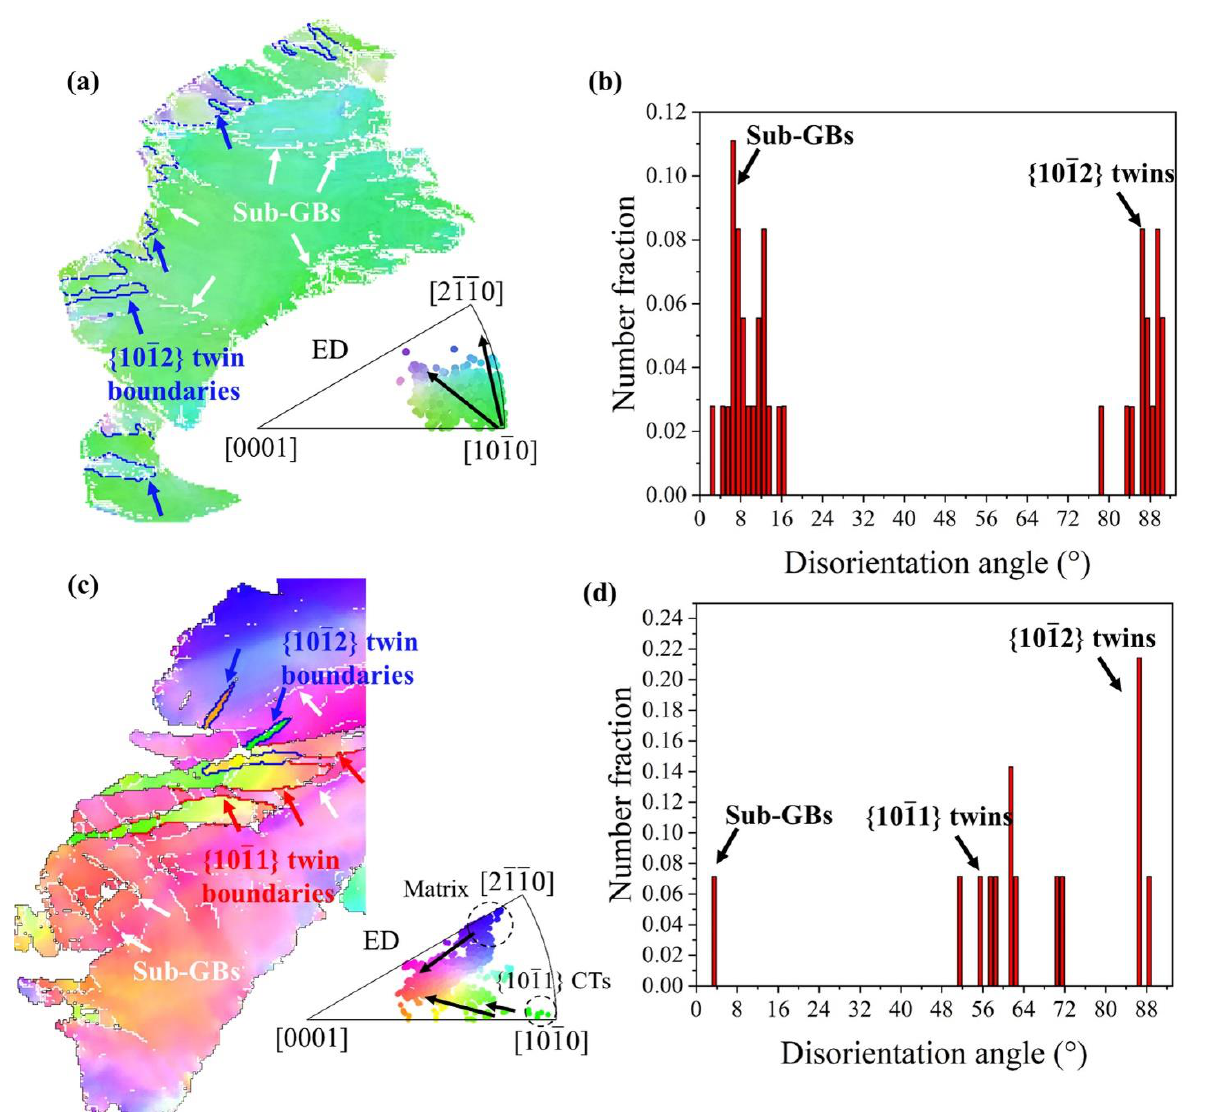
Figure 8. Orientation evolution of deformed matrix: ( a ) deformed grains of area 1, ( c ) deformed grains of area 3; ( b , d ) related disorientation angle distributions.